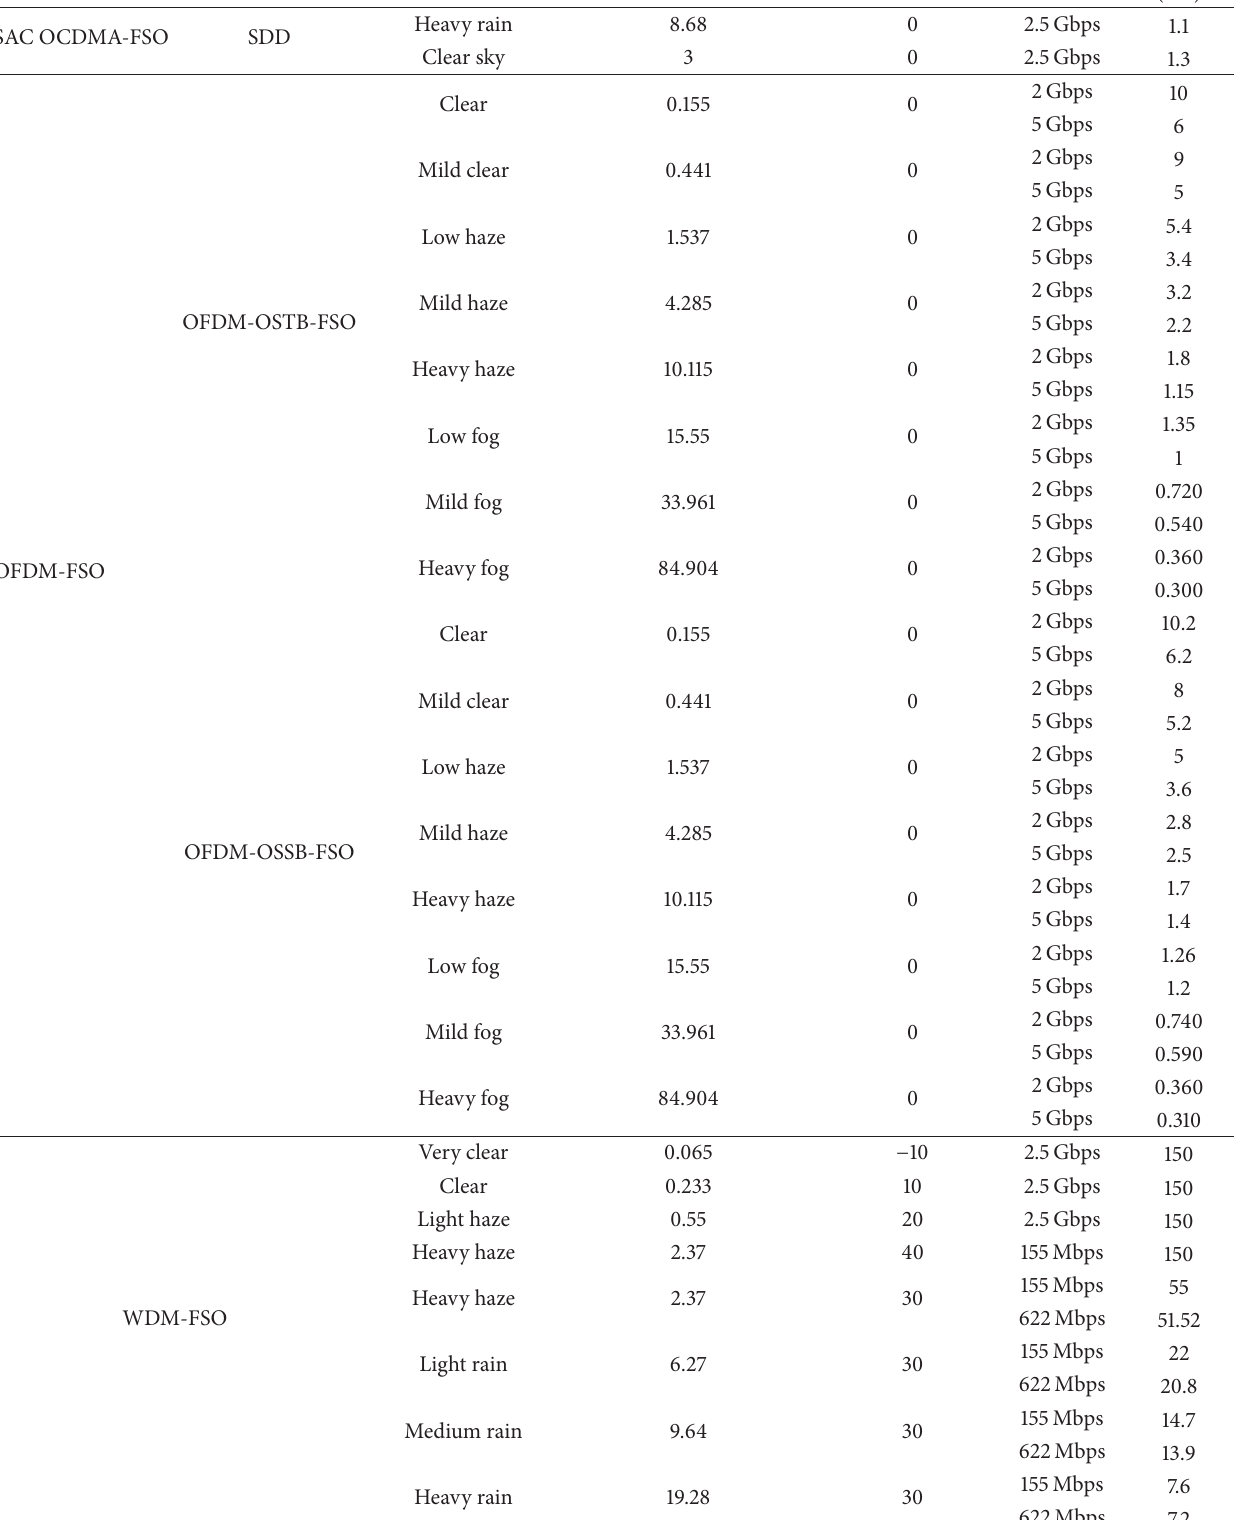
Table 2: Comparison table of various techniques based on system parameters on wavelength of 1550 nm [4, 5, 11, 21].